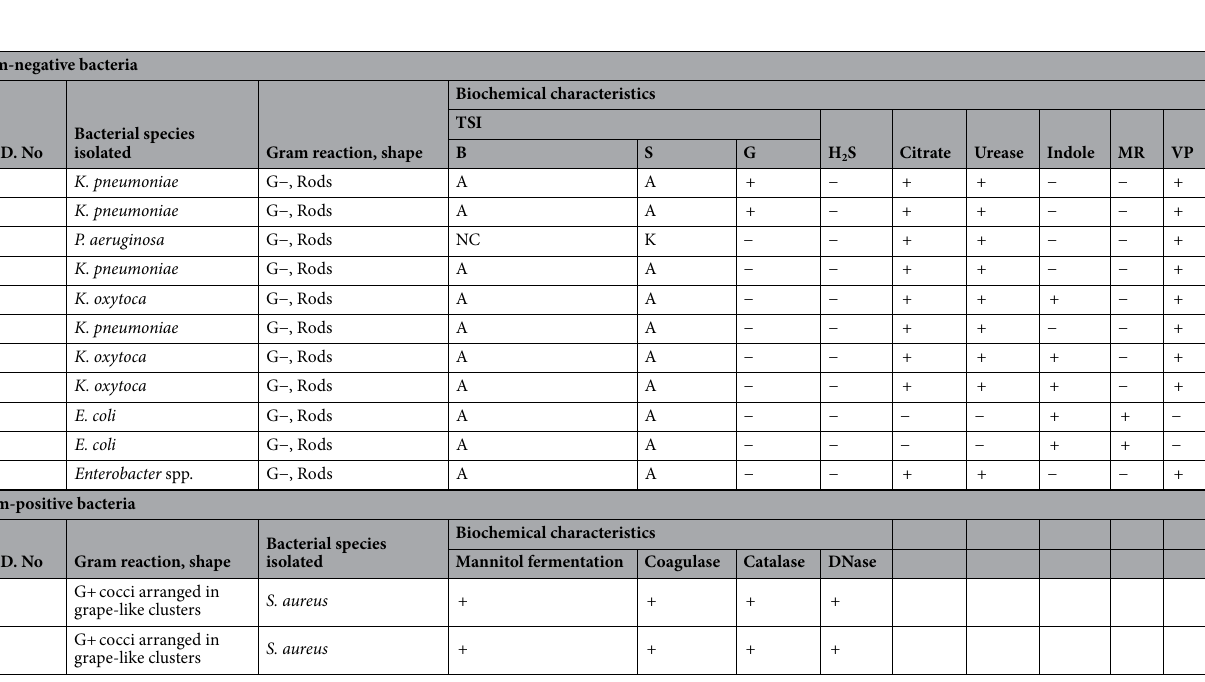
Table 5. Gram staining properties, cellular morphology, and biochemical traits of the representative (a) gram- negative, and (b) gram-positive bacteria isolated from commercial herbal medicines in Kampala city. ID.